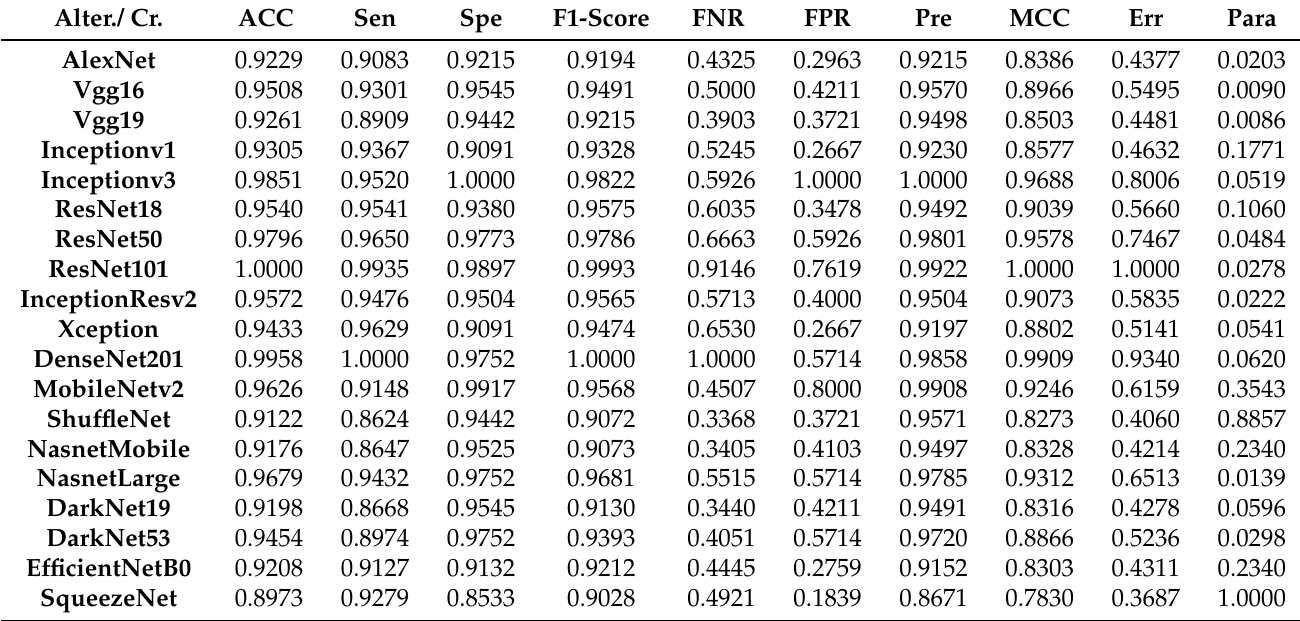
Table 4. Normalized decision matrix. Alter.—alternative; Cr.—criterion. Alter./